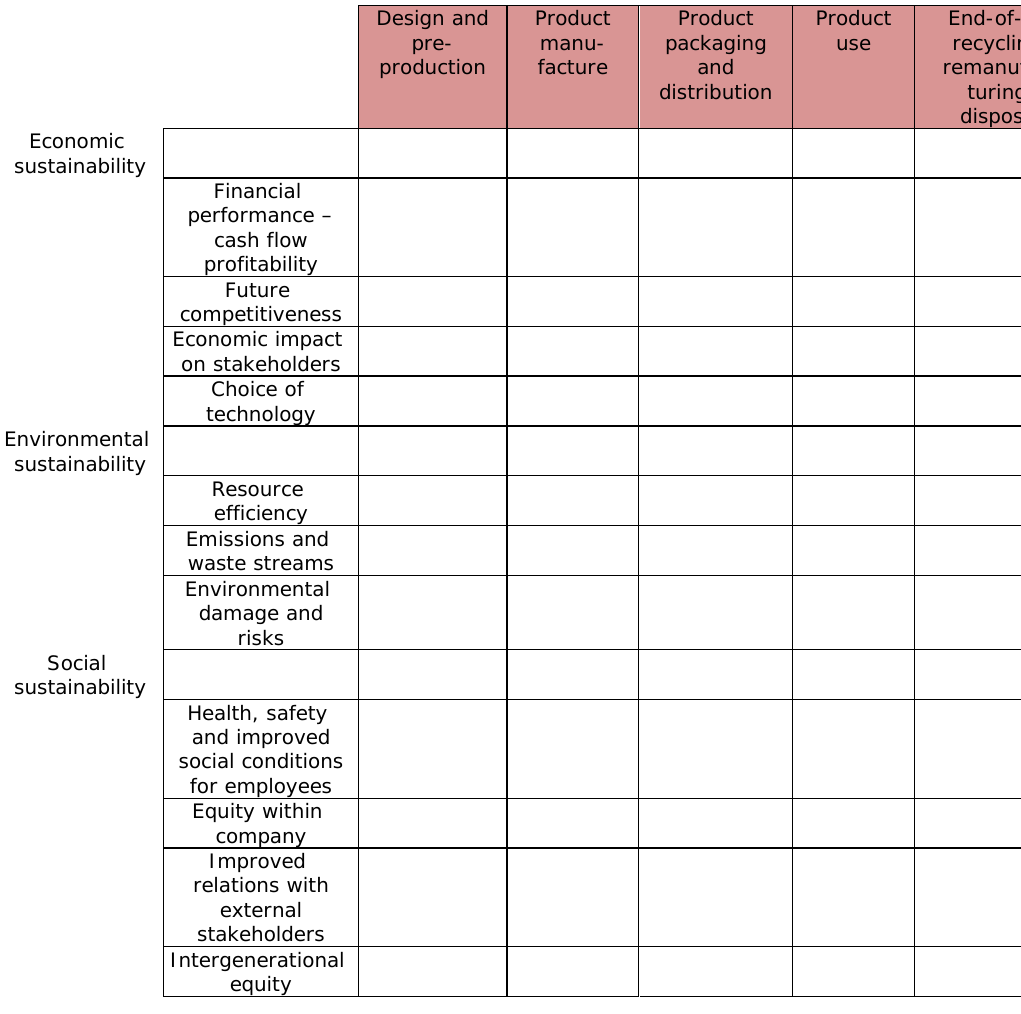
Figure 3. “A typology for sustainable operations management (manufactured product example)”. Integrating life-cycle stages and CSR responses. Source: